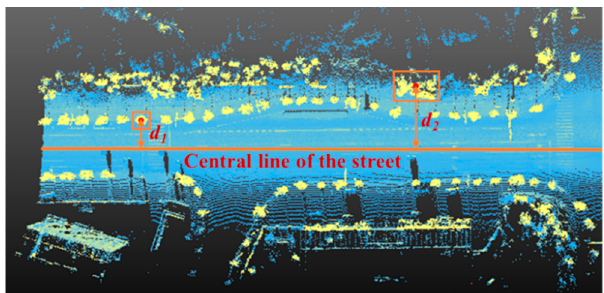
Figure 9. Distances between ground objects and the central line of the street.